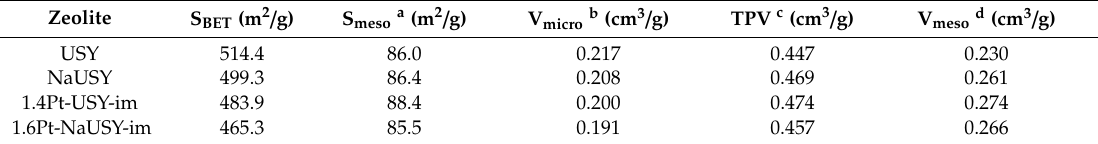
Table 1. Physicochemical and metallic function properties of USY and NaUSY zeolites and 1.4Pt-USY- im and 1.6Pt-NaUSY-im catalysts.